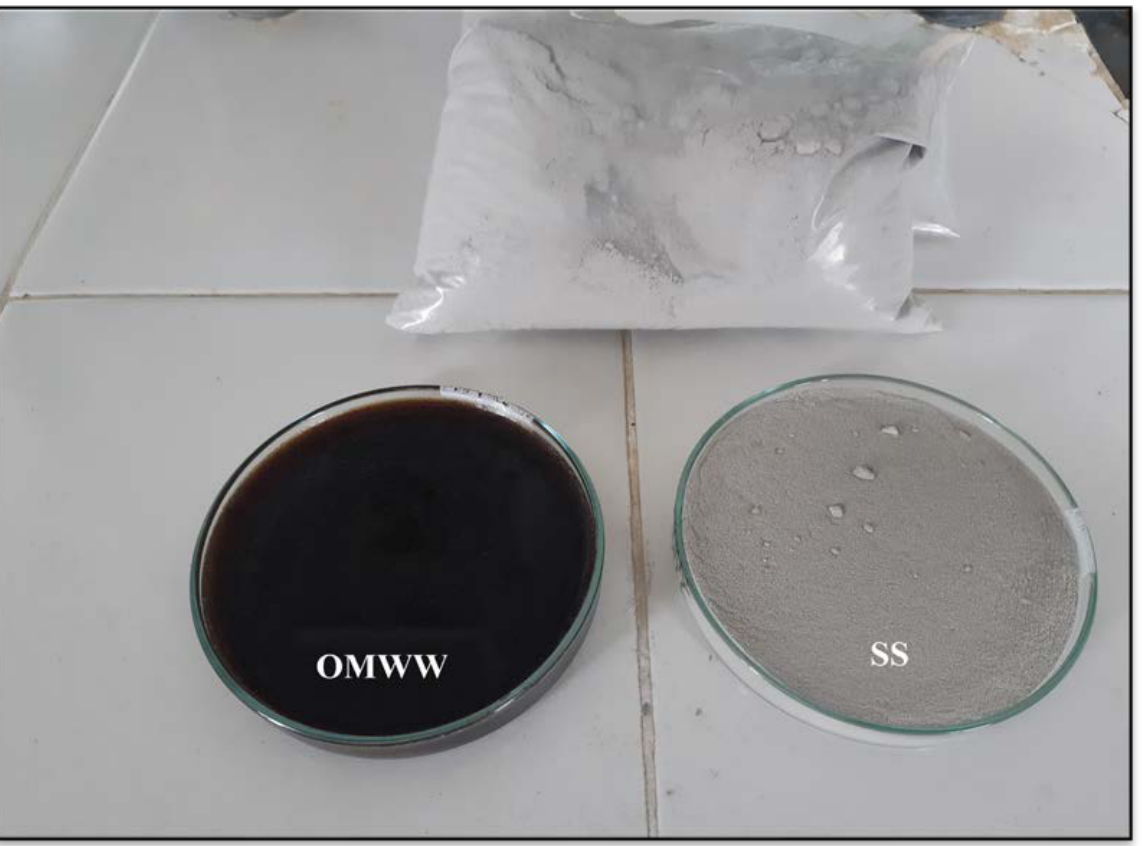
Figure 1. Olive mill wastewater (OMWW) and steel slag (SS) samples.